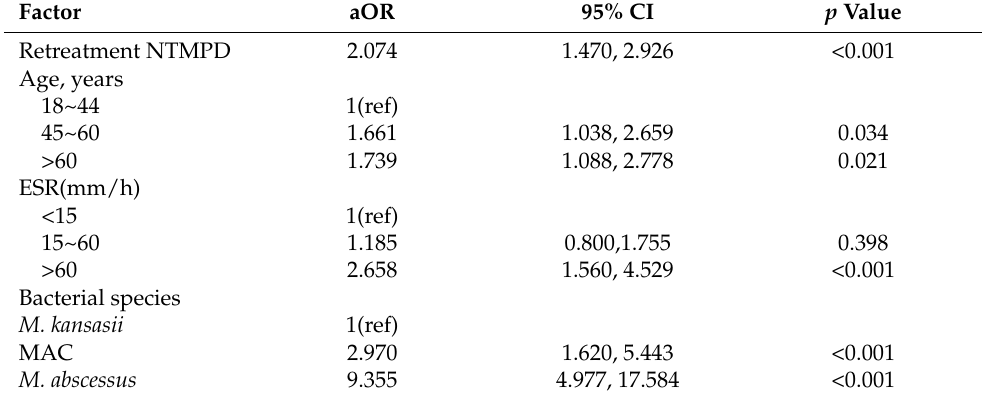
Table 4. Multivariate analysis of factors associated with treatment failure in patients with